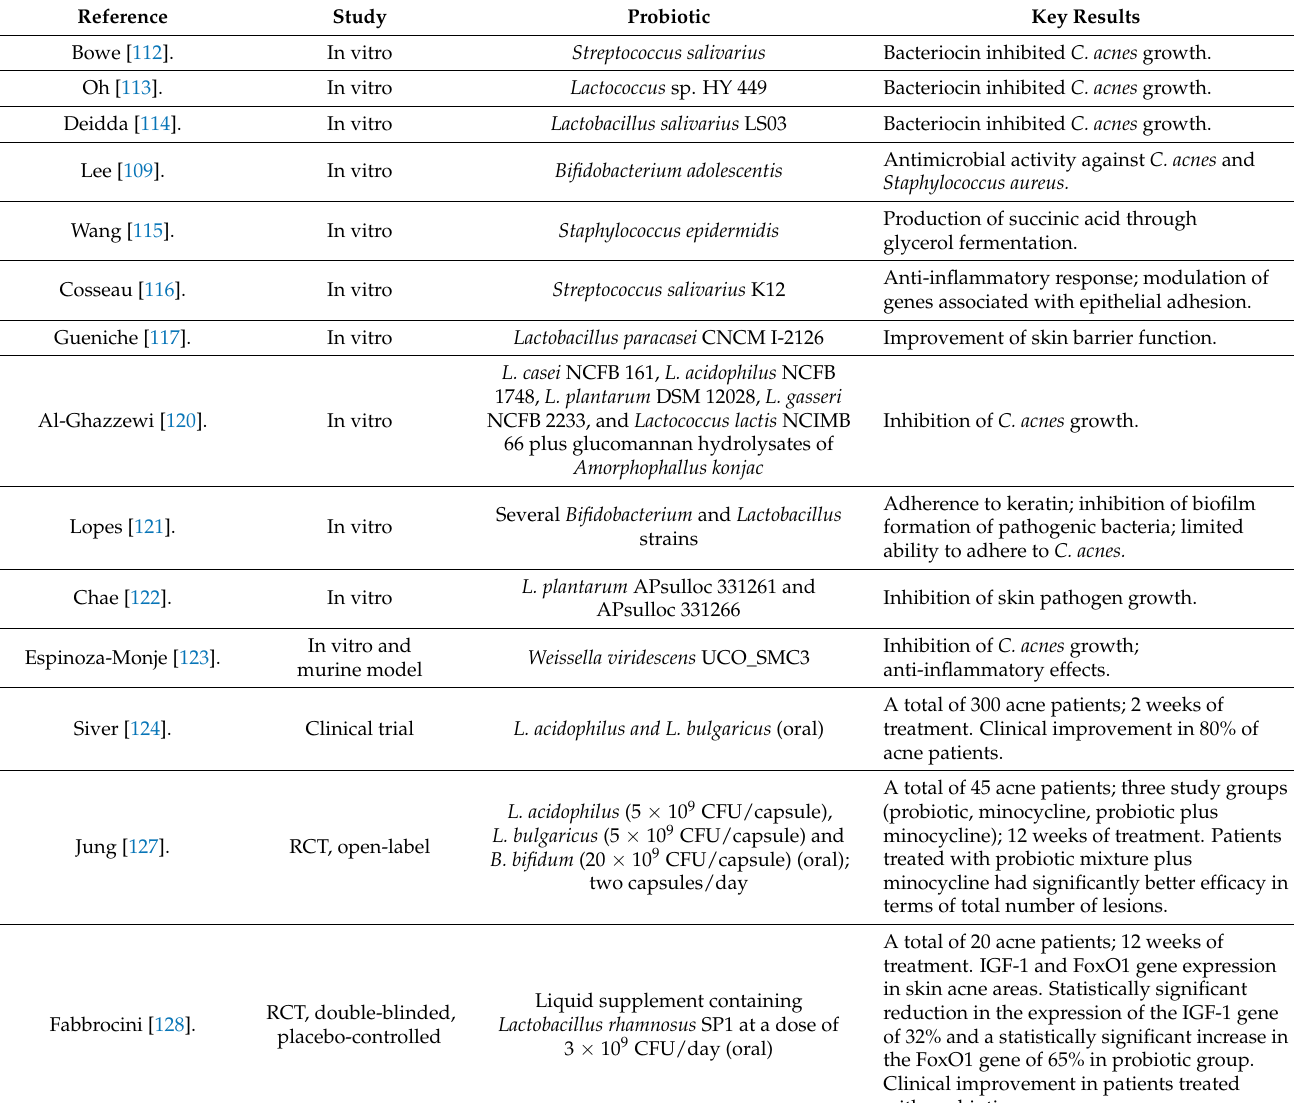
Table 2. Acne vulgaris and